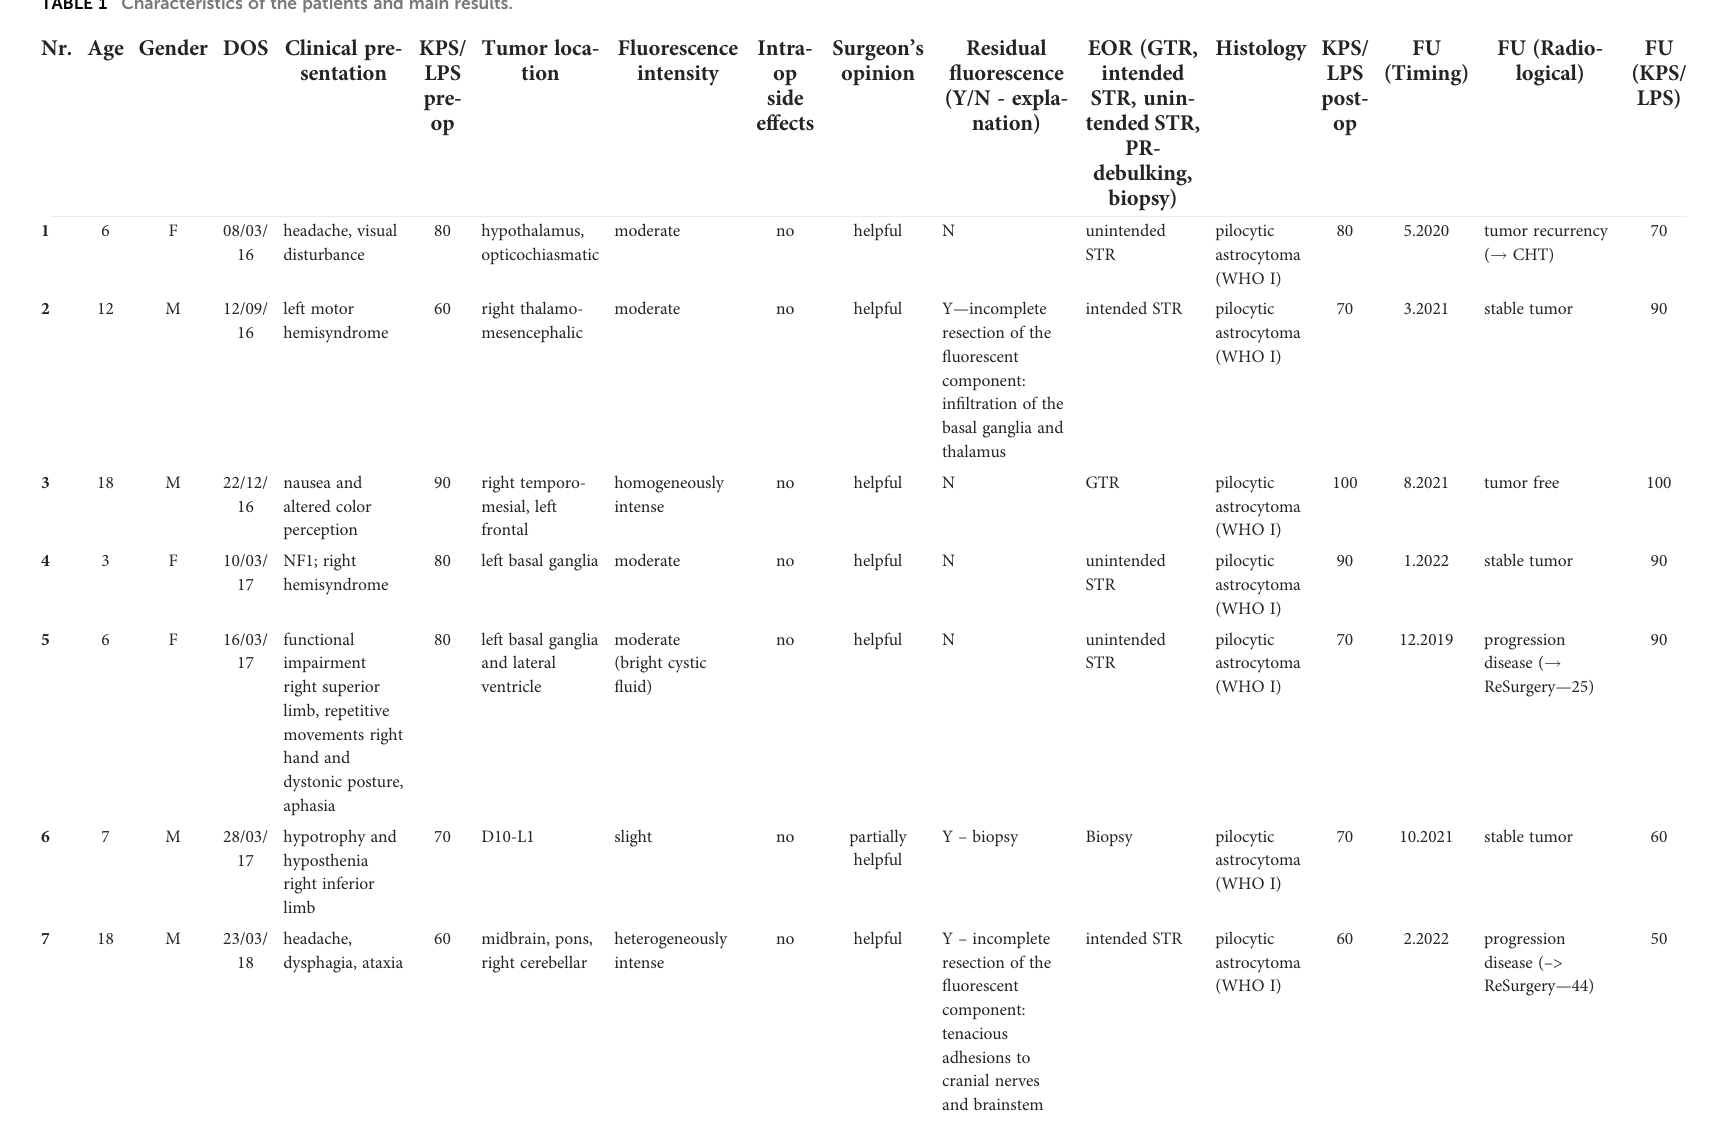
TABLE 1 Characteristics of the patients and main results. Nr. Age Gender DOS Clinical pre-